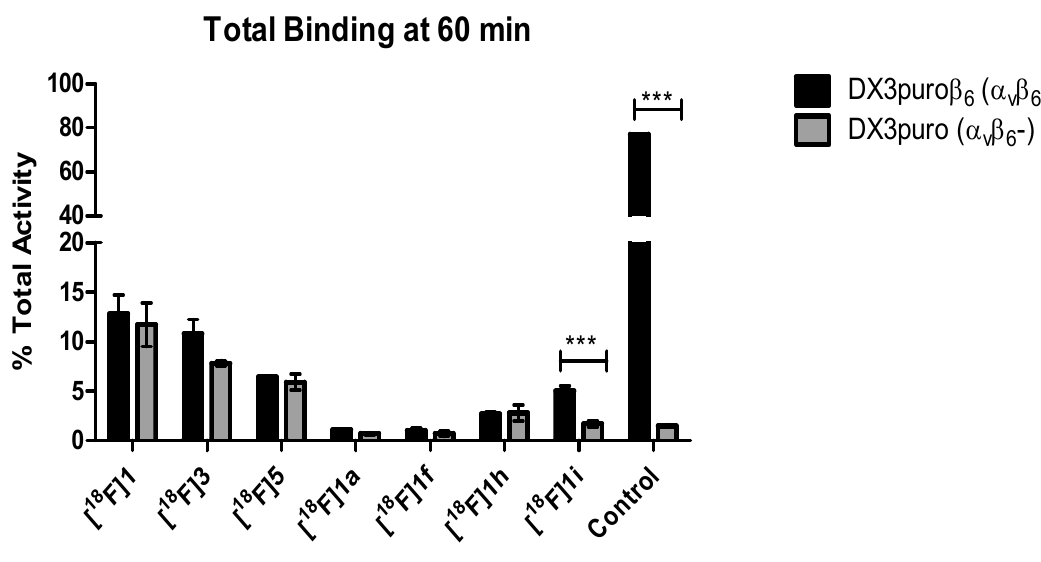
Figure 3. In vitro binding results of [ 18 F]1 , [ 18 F]3 , [ 18 F]5 , [ 18 F]1a , [ 18 F]1f , [ 18 F]1h , [ 18 F]1i and the control peptide after 60 min incubation with either DX3puro β 6 ( α v β 6 + ) or DX3puro ( α v β 6 − ) cell line ( n = 3). *** paired Student t ‐ test gives p < 0.05.